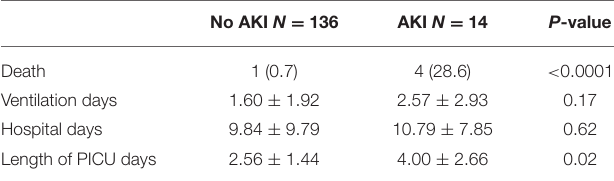
TABLE 4 | Clinical outcomes of patients ( N =